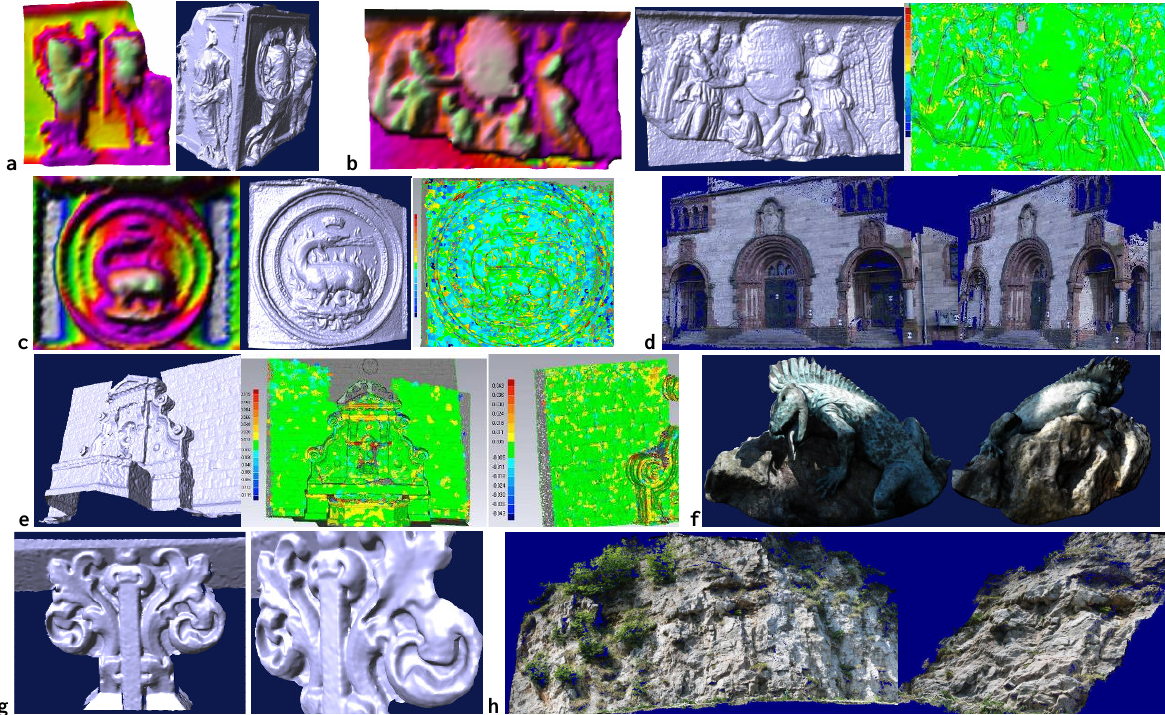
Figure 2. Some results obtained with MPGC+ for the reconstruction of 2.5D and 3D